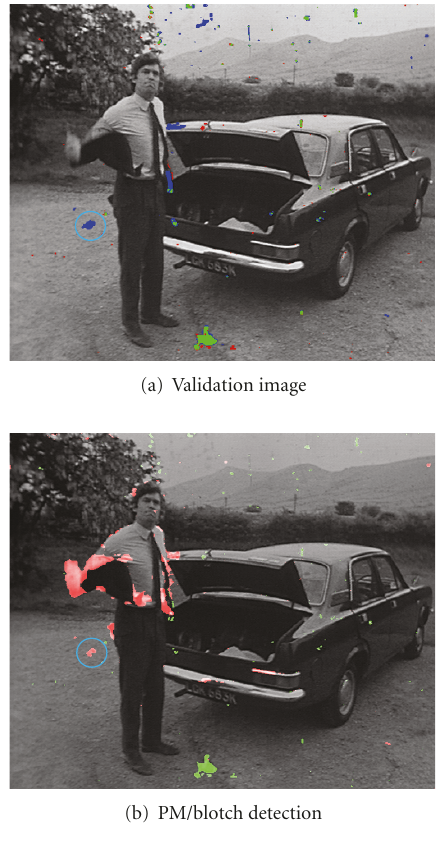
Figure 8: This figure shows a validation image and a PM/blotch detection for the “jacket” sequence (correct detections—green, missed detections—blue, false alarms—red). The PM/blotch (red/ green) images can be used to indicate whether or not a missed blotch detection occurs to the pixel being detected as PM (blue